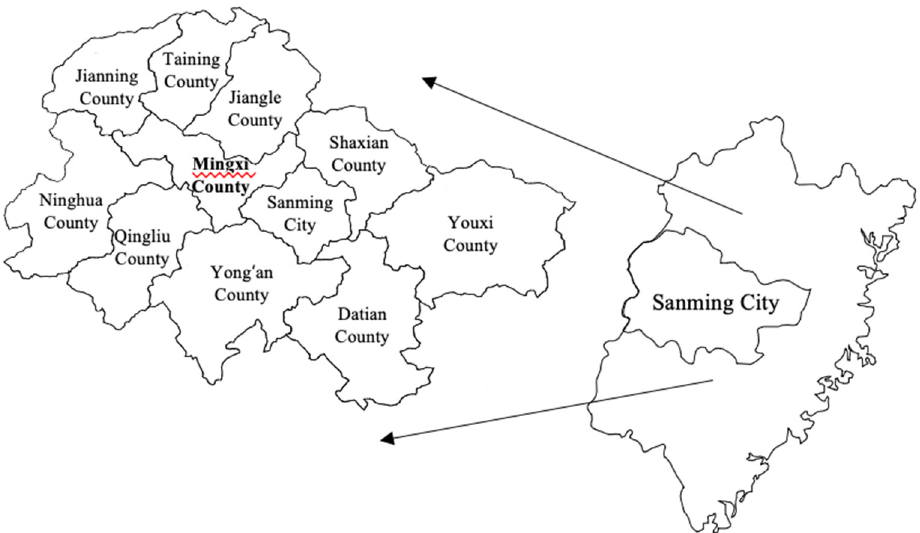
Figure 1. Study Figure 1. Study area.